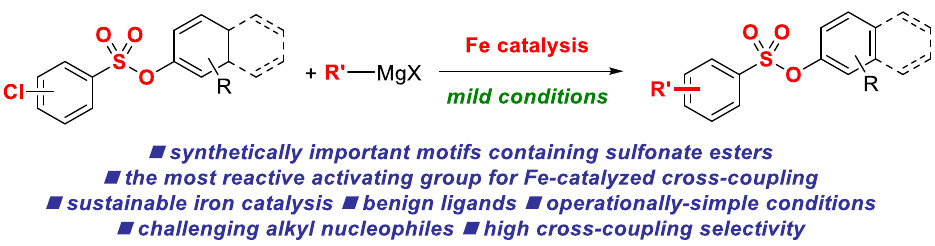
Figure 2. Iron-catalyzed C(sp 2 )–C(sp 3 ) cross-coupling of aryl chlorobenzenesulfonates with alkyl Grignard reagents (this